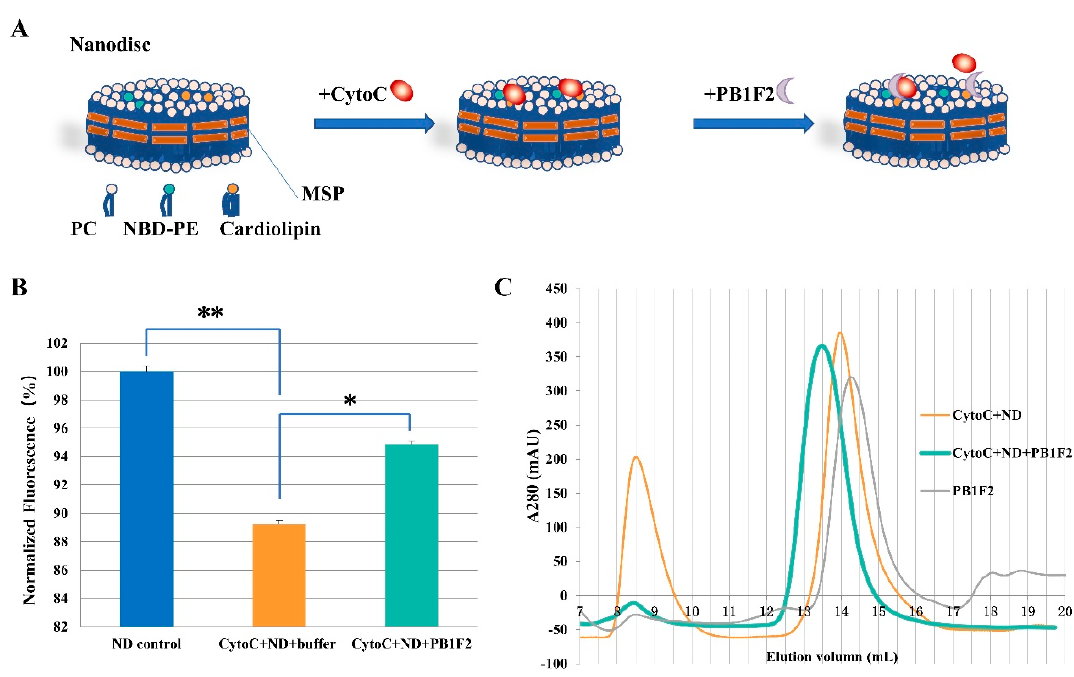
Figure 3. PB1F2 regulate the interaction between cytochrome c (Cyto C) and cardiolipin on Nanodiscs (ND). ( A ) schematic diagram of the nanodiscs fluorescence assay; ( B ) interaction of cytochrome c and PB1F2 with cardiolipin leads to the difference in nanodisc fluorescence. Nanodiscs were incorporated with POPC, cardiolipin, and NBD-PE. PB1F2 was added to the cytochrome C and liposome mixture after 30 minutes of incubation at room temperature. The fluorescence of the samples was recorded at excitation/emission 460/535 nm using a microplate reader. Data were pooled from three independent experiments and the results were represented as mean ± SD. * p < 0.05, ** p < 0.01. ( C ) The adding of PB1F2 to the mixture of cytochrome C and nanodisc (ND) resulted in a larger molecular weight component (Green). SEC analysis was carried out after 30 minutes of